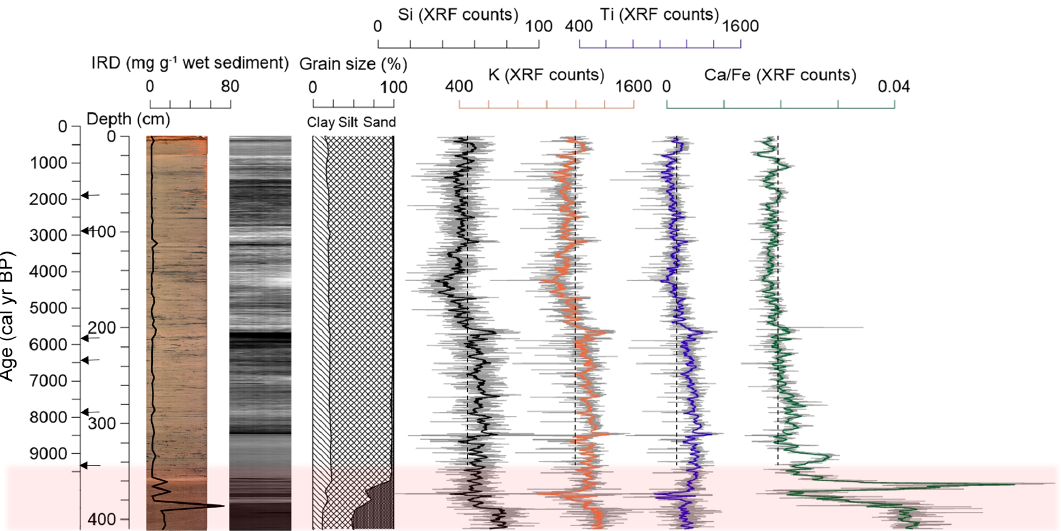
Figure 3. Results of the sedimentological and XRF core scanning analyses of core DA17-NG-ST07-73G. From left to right, photograph of the core with the amount of IRD (black line), radiograph, grain size analysis, and XRF counts of selected elements are shown. Dashed black lines in the XRF curves represent the mean of the values measured throughout the core. Black arrows next to the left y axis (age) mark radiocarbon dates. The bottom 65cm of the sediment core is marked with pink colour. The photograph and radiograph of the core were horizontally